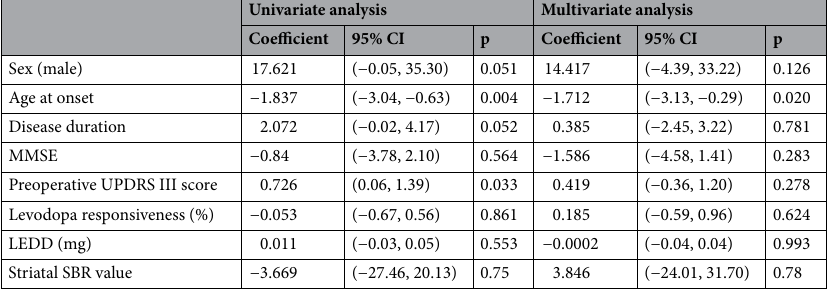
Table 2. Univariable and multivariate regression analysis of the factors associated with the DBS motor responsiveness in patients with advanced Parkinson’s disease who underwent GPi DBS. DBS, deep brain stimulation; GPi, globus pallidus interna; MMSE, Mini-Mental State Examination; SBR, specific binding ratio; LEDD, levodopa equivalent daily dose; UPDRS, Unified Parkinson’s Disease Rating Scale.